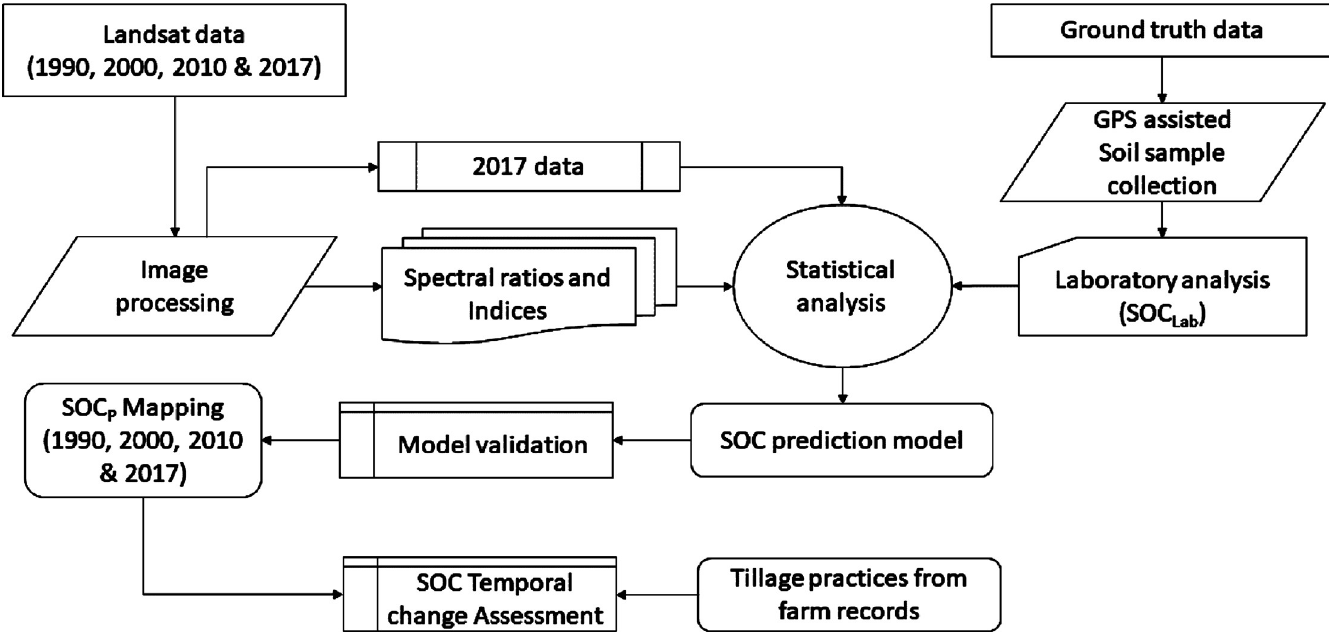
Fig 2. Procedure of soil organic carbon mapping.